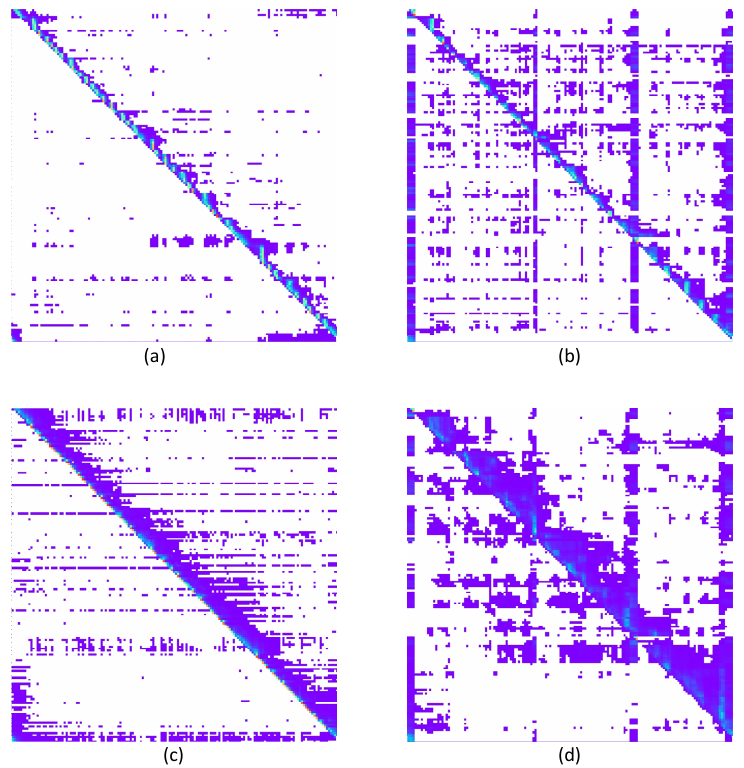
Figure 3. ( a ) Encoder first-layer attention matrix heat map. ( b ) Encoder fourth-layer attention matrix heat map. ( c ) Encoder eighth-layer attention matrix heat map. ( d ) Encoder twelfth-layer attention matrix heat map.